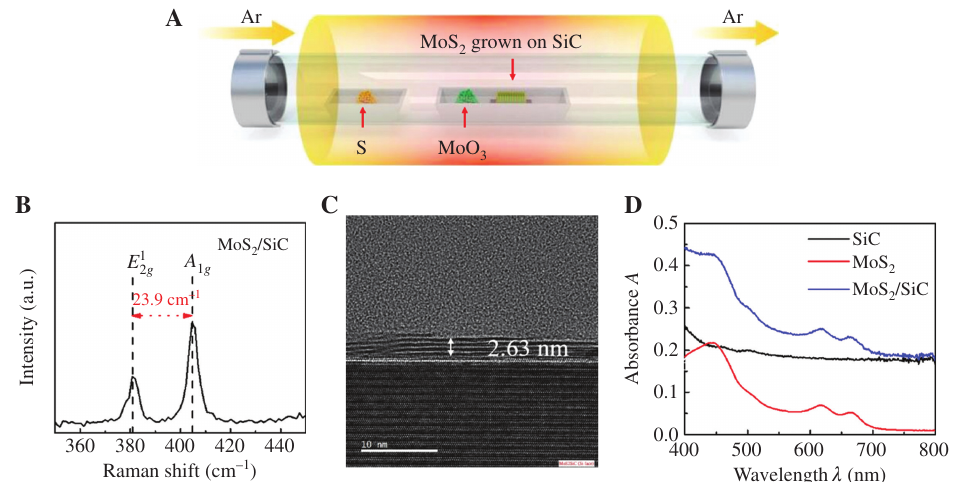
grown on SiC by direct CVD. 2 grown on monocrystalline SiC by direct CVD under Ar atmosphere, in which MoS 2 on SiC. The difference between the Raman peaks 1 2 /SiC sample. (D) Absorbance of MoS 2